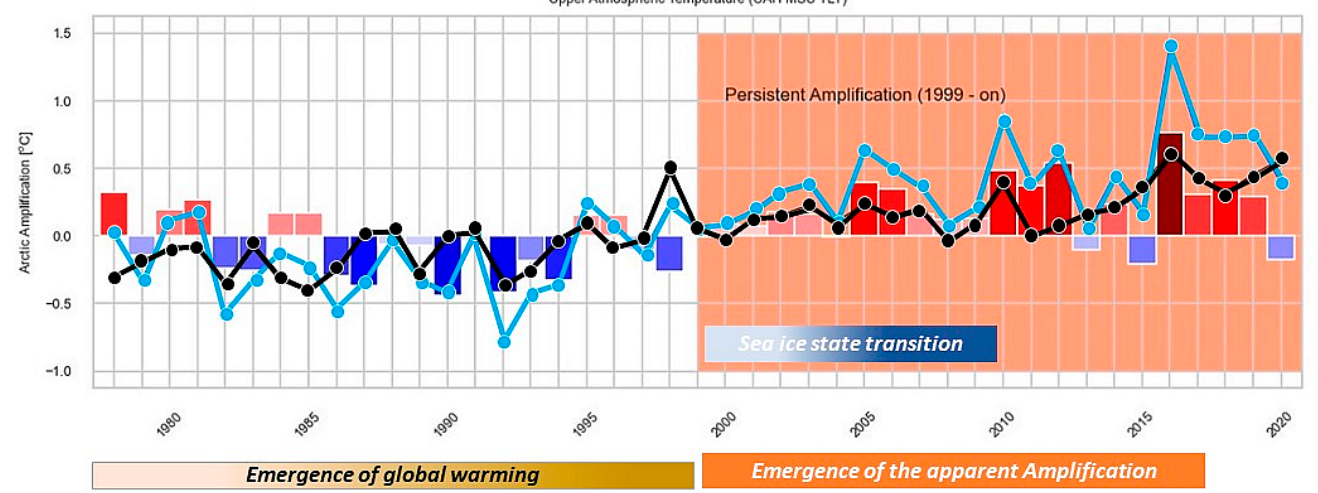
Figure 4. The amplification in the satellite observations (the lower troposphere UAH MSU TLT data set) with sketched periods of the apparent amplification emergence. The blue line shows the Arctic temperature anomalies; the black line shows the Northern Hemisphere temperature anomalies; the colored bars show the amplification (the difference Δ (cid:3002)(cid:3002) between the lines).